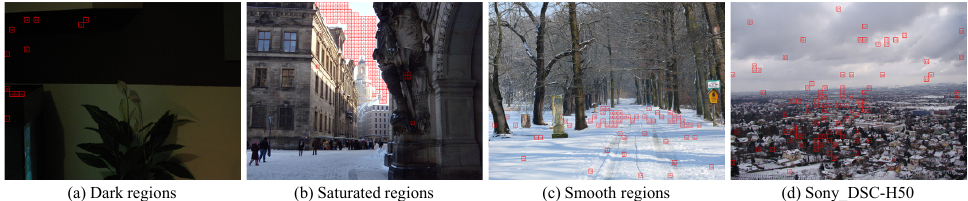
Figure 11. Failure examples of the proposed method at model level